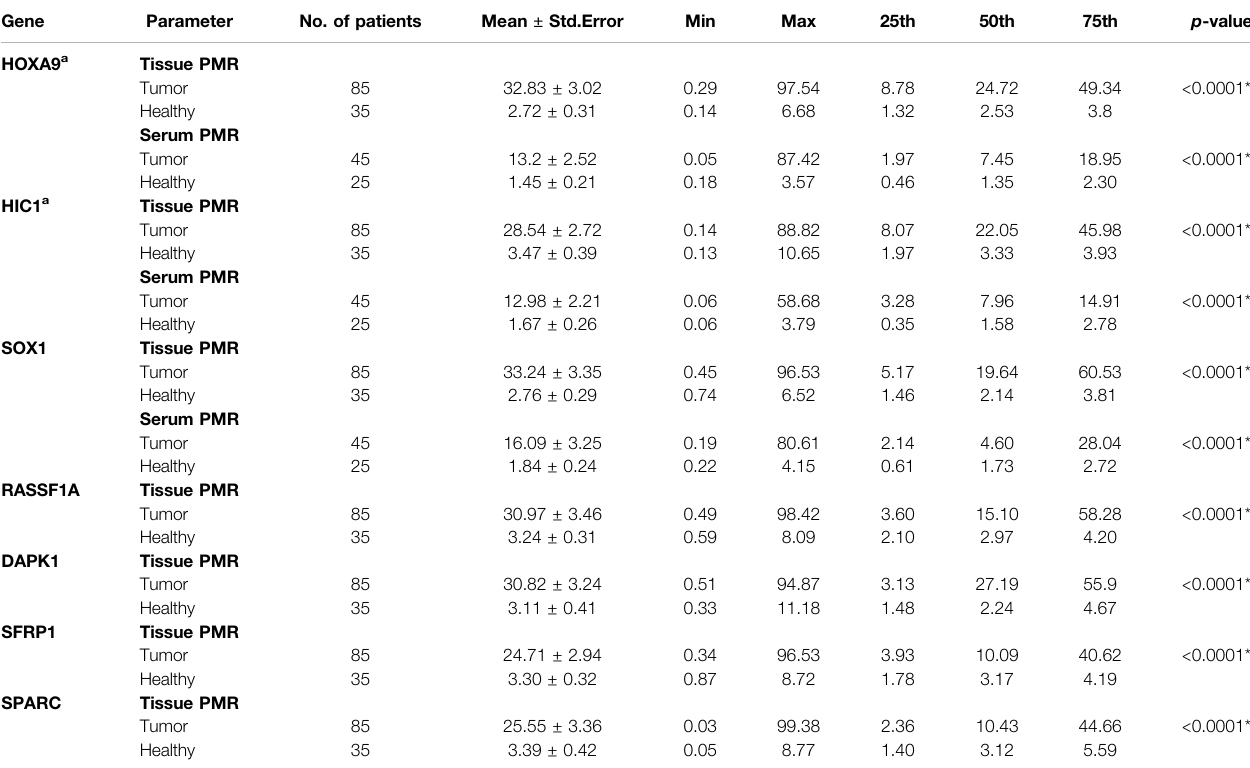
TABLE 1 | PMR value of candidate genes in tissue and serum samples of patients with epithelial ovarian carcinoma and healthy control group. PMR: percentage of methylated reference. p -value: Mann-Whitney U two-tailed tests. a The PMR value of HOXA9 and HIC1 gene in tissue and serum samples of patients with epithelial ovarian carcinoma and healthy control group has been previously described (Singh et al.,